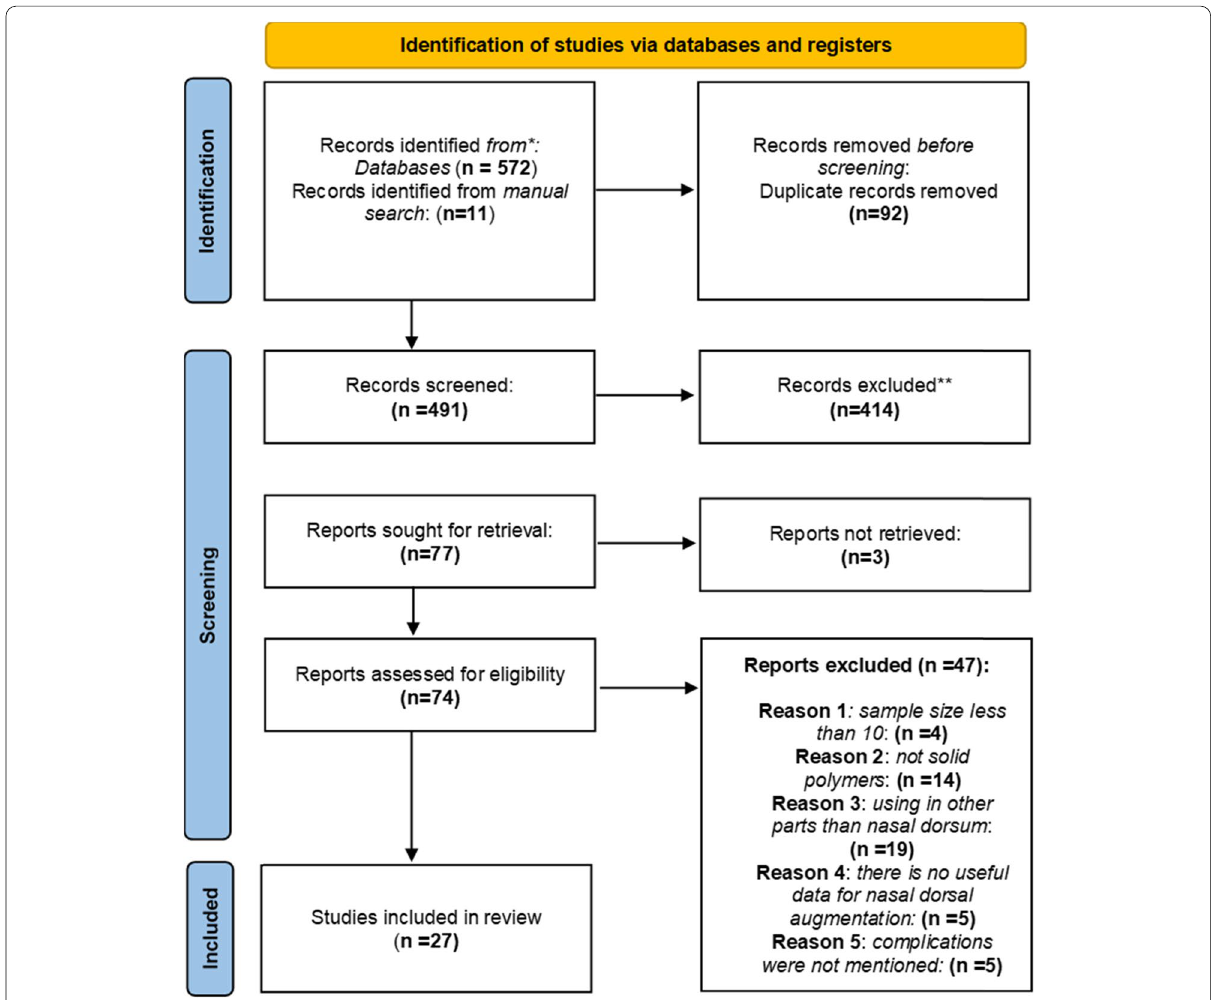
Fig. 1 PRISMA Flowchart for study